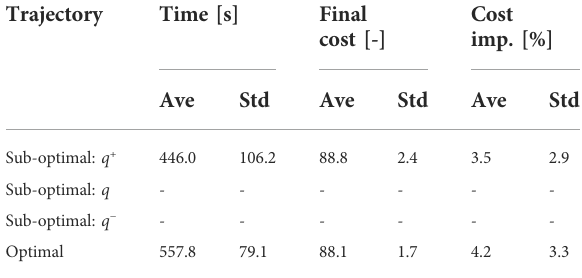
TABLE 6 Simulation result in terrain roughness 0.281 (goal B): C 0 =92.1 ±